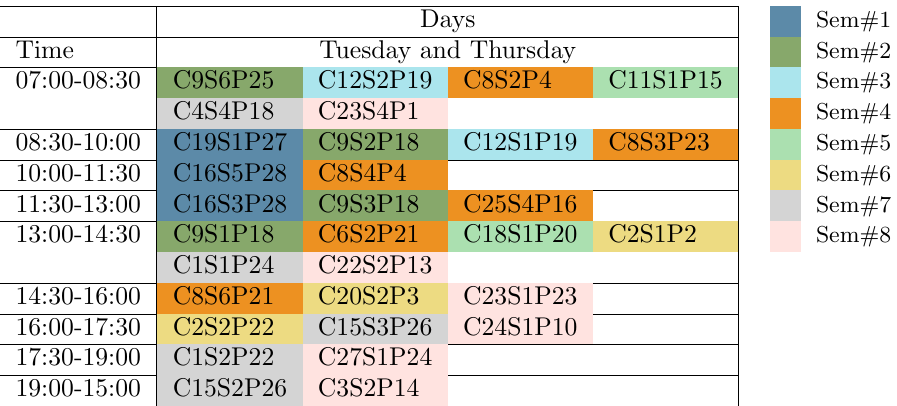
Figure 6. Timetable of third strategy for courses in day scheme A: Monday, Wednesday and Friday, three classes of 1 h per week.